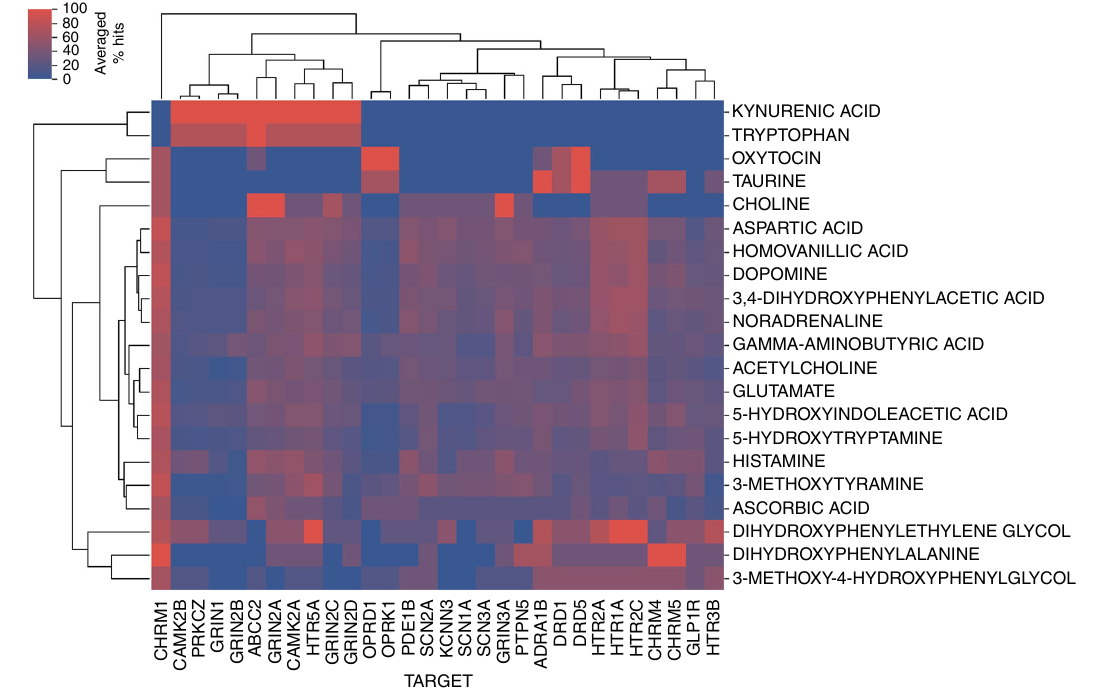
Fig. 5 Systematic analysis of bioactivities against protein targets associated with neurochemical changes. A larger percentage (red) indicates which protein targets are more often predicted to be targeted by drugs which change a given neurotransmitter level. Target families are shown to frequently cluster together, due to their similarity in bioactivity pro fi les (i.e. compounds which elicit neurochemical response more frequently interact at a complement of targets within protein families), as illustrated by the voltage-gated sodium channel Alpha subunit 1 and type III subunit (SCN1A and SCN3A) and the cholinergic muscarinic receptors 4 and 5 (CHRM4 and CHRM5) also corroborated in literature 56,57 . N.B.: Only drug targets that are clustering to at least three neurochemicals are listed here